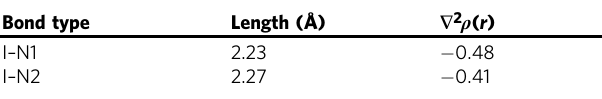
Table 1 Bond critical point data for the I – N bonds in at 100 GPa.